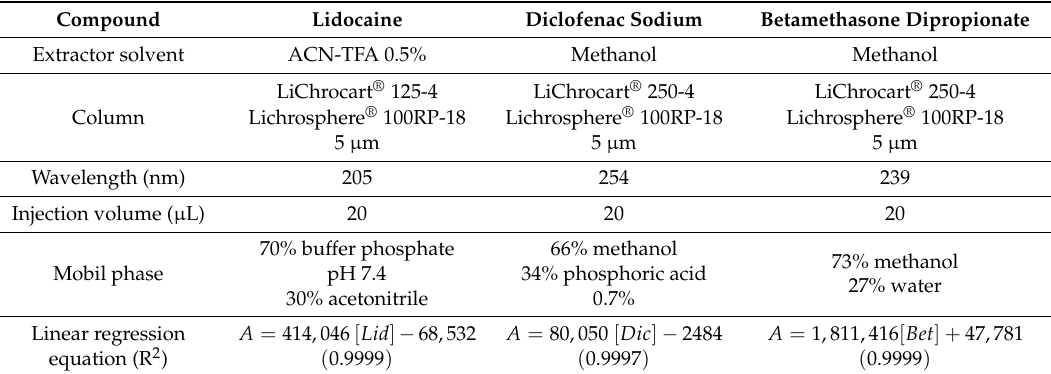
Table 1. HPLC analytical conditions for lidocaine (Lid), diclofenac sodium (Dic) and betamethasone dipropionate